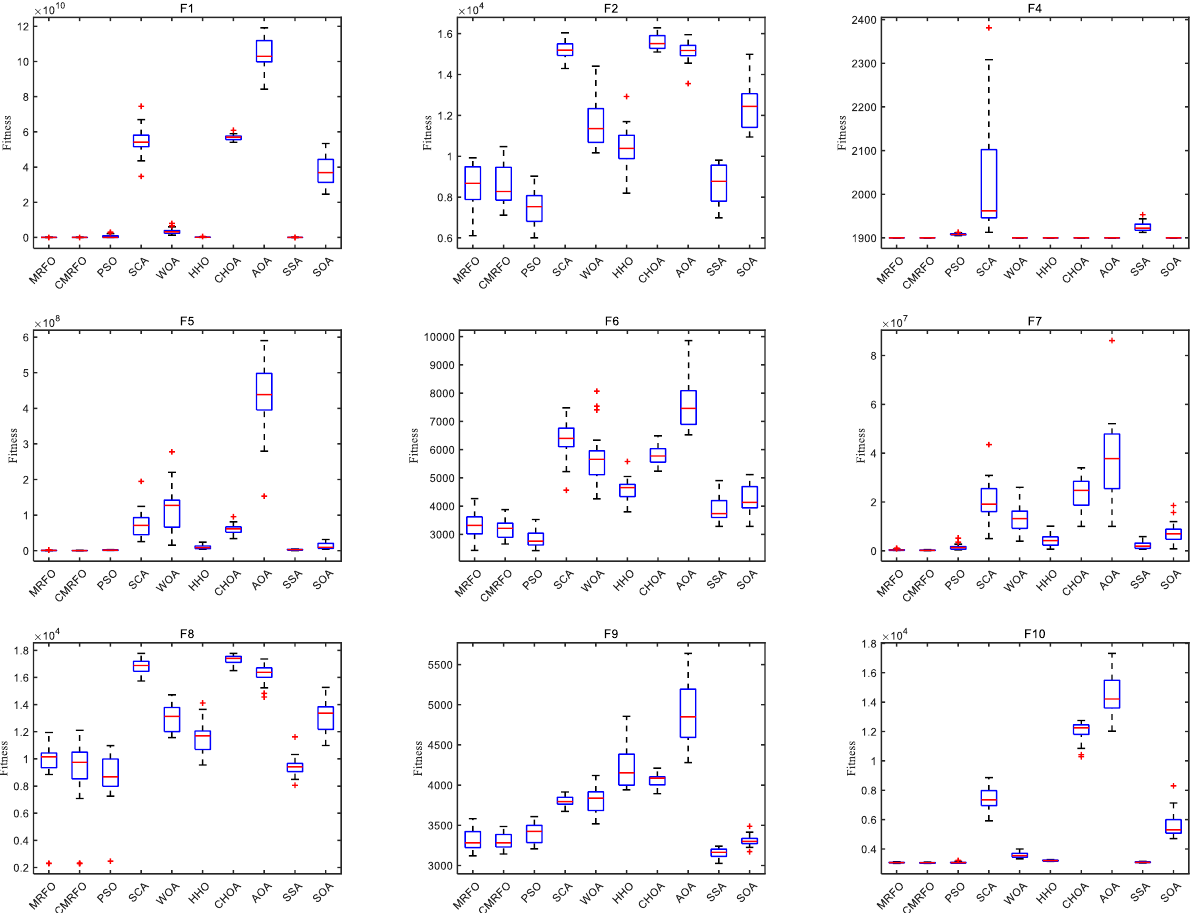
Figure 7. Boxplots of all 10 algorithms on the 50-dimensional CEC2020 test suite.